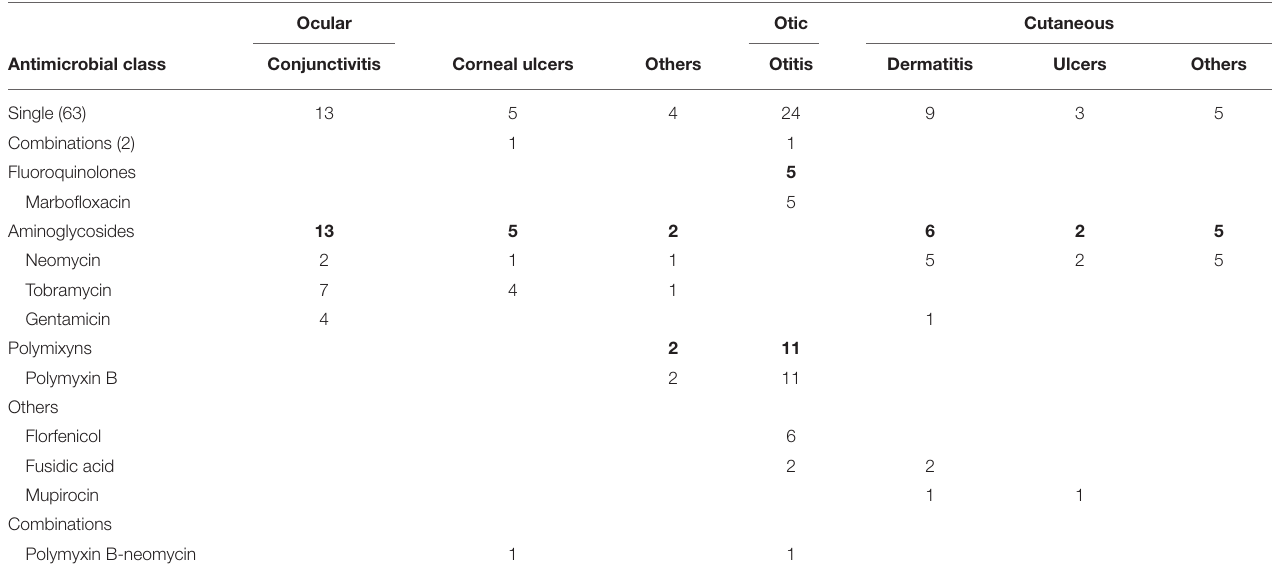
TABLE 4 | Distribution of antimicrobials of 65 topical medicinal products according to administration route and conditions treated, on 300 urban dogs (Madrid City). Ocular Otic Cutaneous Antimicrobial